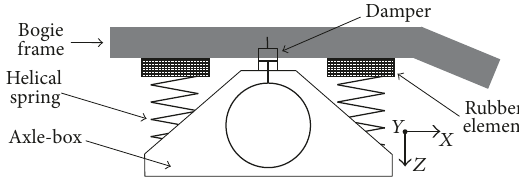
Figure 3: Primary suspension scheme of the rubber element located at the extremity of the helical spring.